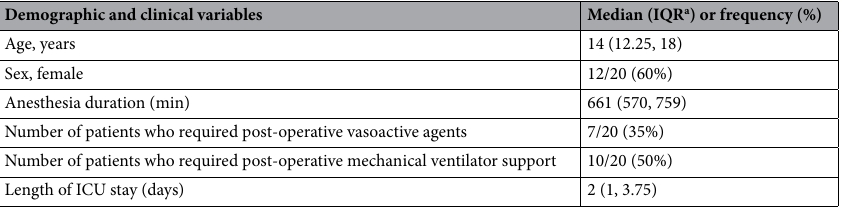
Table 1. Demographic and Clinical Variables for the Patient Cohort. Twenty patients were enrolled in the study. This table has been Modified from reference 4 . IQR interquartile range represented as 25th percentile, 75th percentile; EN, enteral nutrition; ICU, intensive care unit; IQR, interquartile